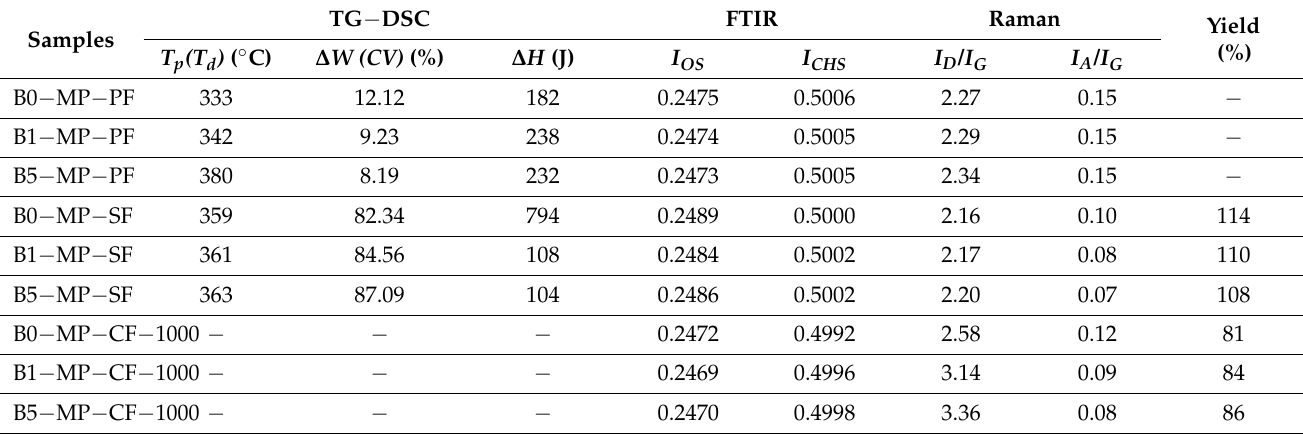
Table 1. General properties of PFs, SFs and